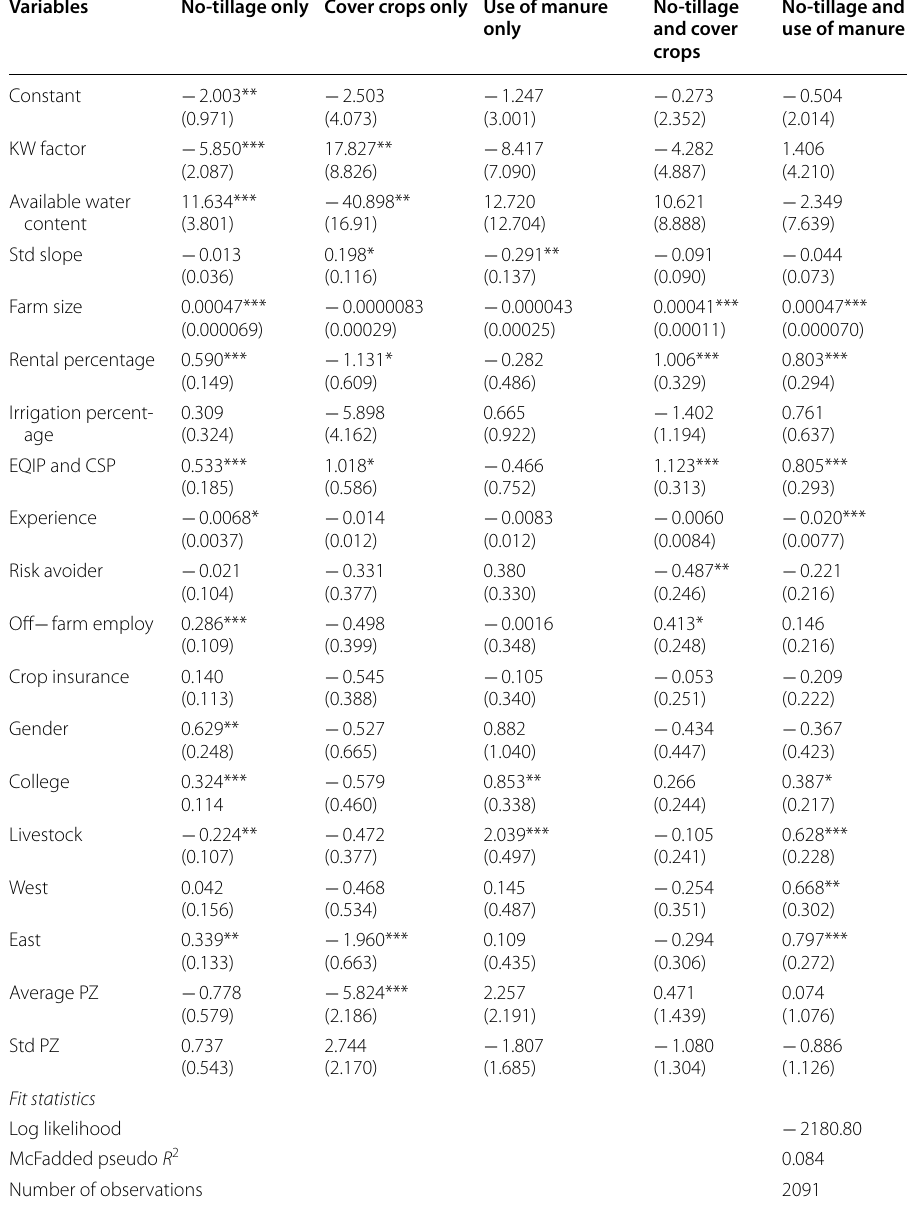
Standard errors are presented in parentheses ***,**,* indicate statistical significant at 1%, 5% and 10% level,